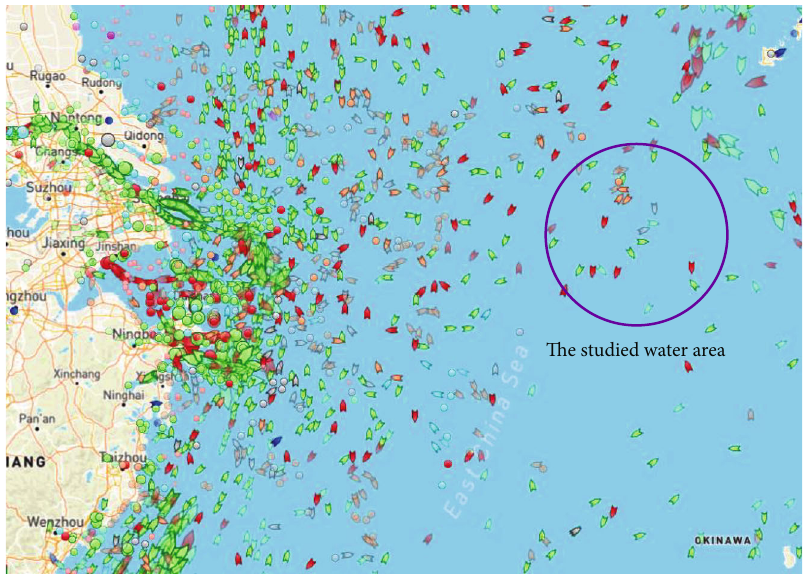
Figure 12: The water area selected for validation.